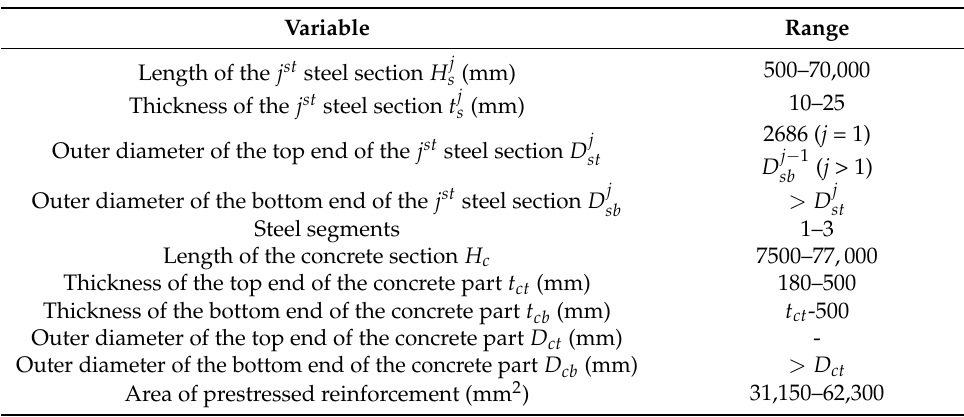
Figure 4. Design parameters of the tower. Table 3. Variables and their